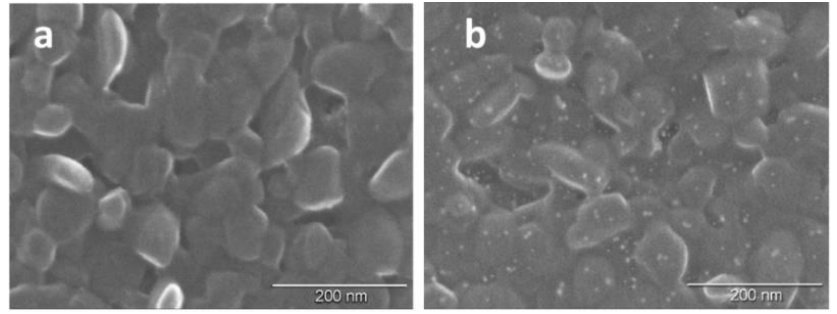
Figure 7. Surface morphology of a VOPc film ( a ) and VOPc film covered with Pd nanoparticles (20 cycles) ( b ).